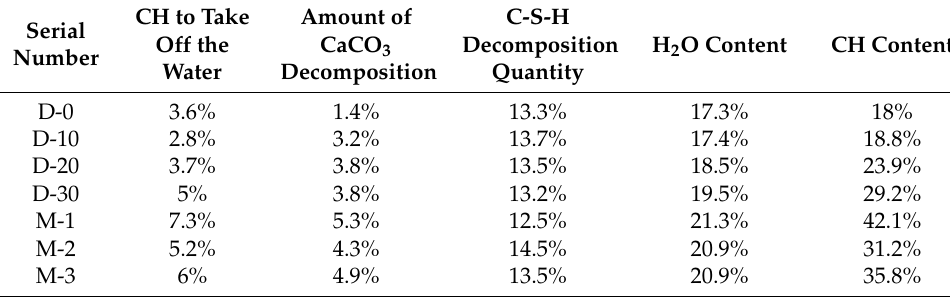
Table 6. TG test the yield table of each